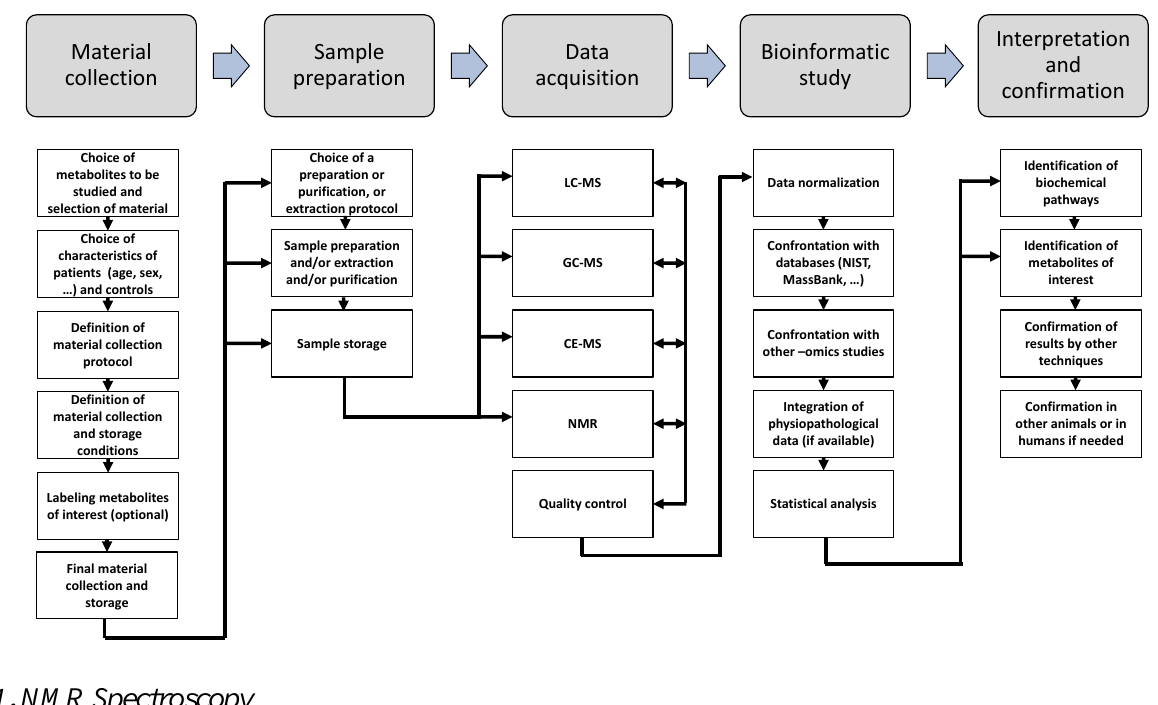
Figure 2. Schematic representation of workflow usually used in metabolomics